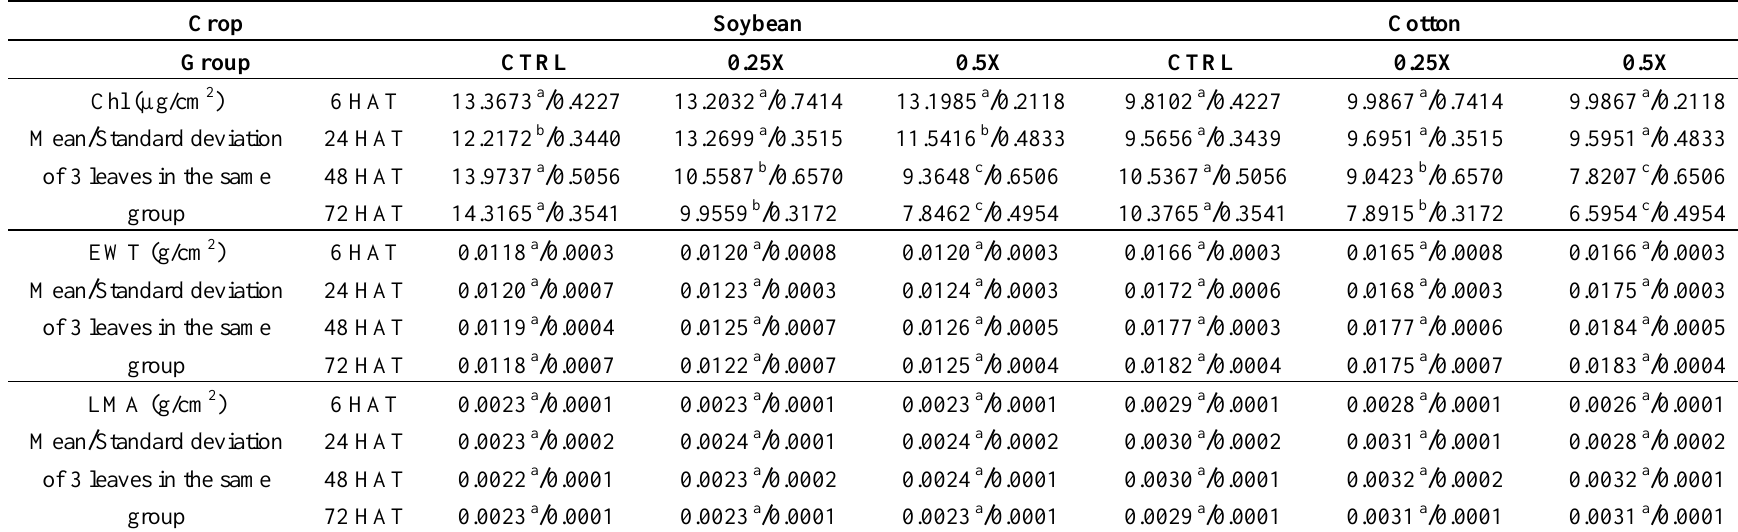
Table 2. Leaf biochemical measurements of soybean and cotton leaves acquired in the second experiment conducted on 4–7 February 2013. The mean values and standard deviations of the biochemical parameters (Chlorophyll content, Chl; Equivalent Water Thickness, EWT; Leaf Mass per Area, LMA) measured for each treatment group (CTRL group with no glyphosate treatment; 0.25X group treated with 0.217 kg·ae/ha solution of glyphosate; 0.5X group treated with 0.433 kg·ae/ha solution of glyphosate) at each time period after treatment (6, 24, 48, and 72 h After Treatment (HAT)) are shown in the table. The separation analysis of the mean values was conducted using Duncan’s multiple range test.